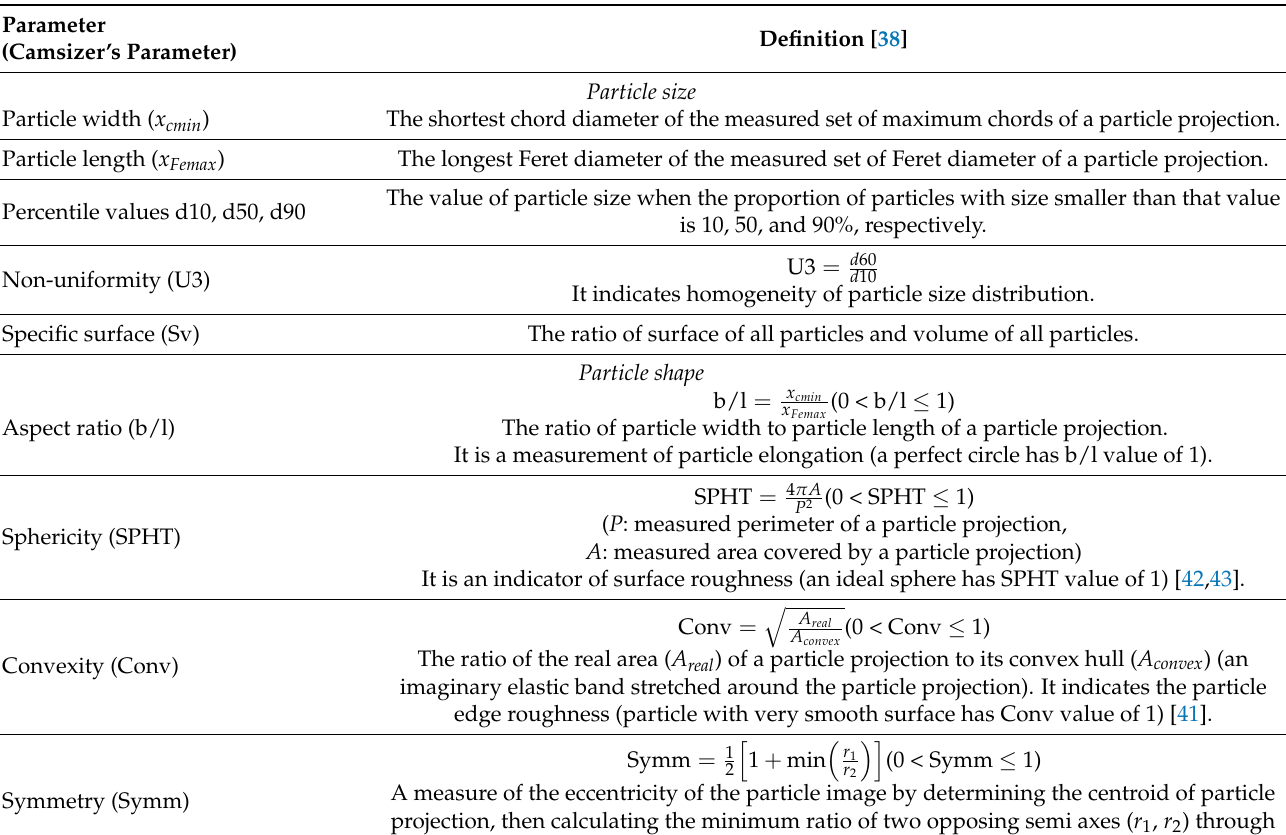
Table 2. Volumetric parameters of particle size and shape analyzed with Particle Analyzer